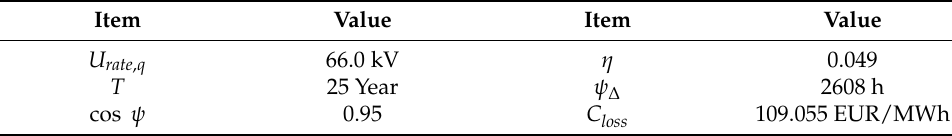
Table A1. Other basic technical and economic data of the wind farm.